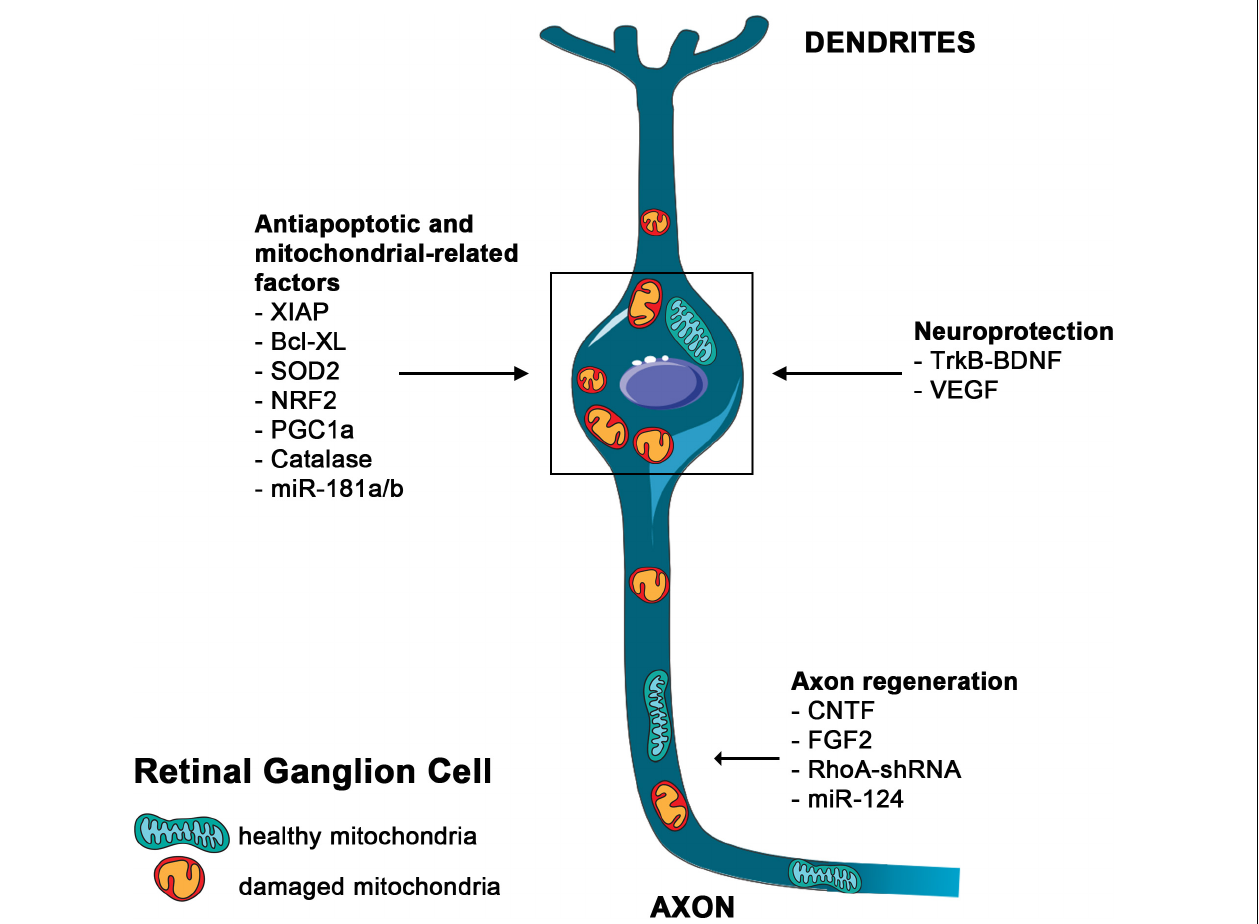
FIGURE 2 | Main mutation-independent therapies applicable to RGC neuroprotection. Schematic representation of an RGC. Damaged mitochondria are depicted in the soma and along the axon. Therapies aimed to block RGCs death and to induce axon regeneration are